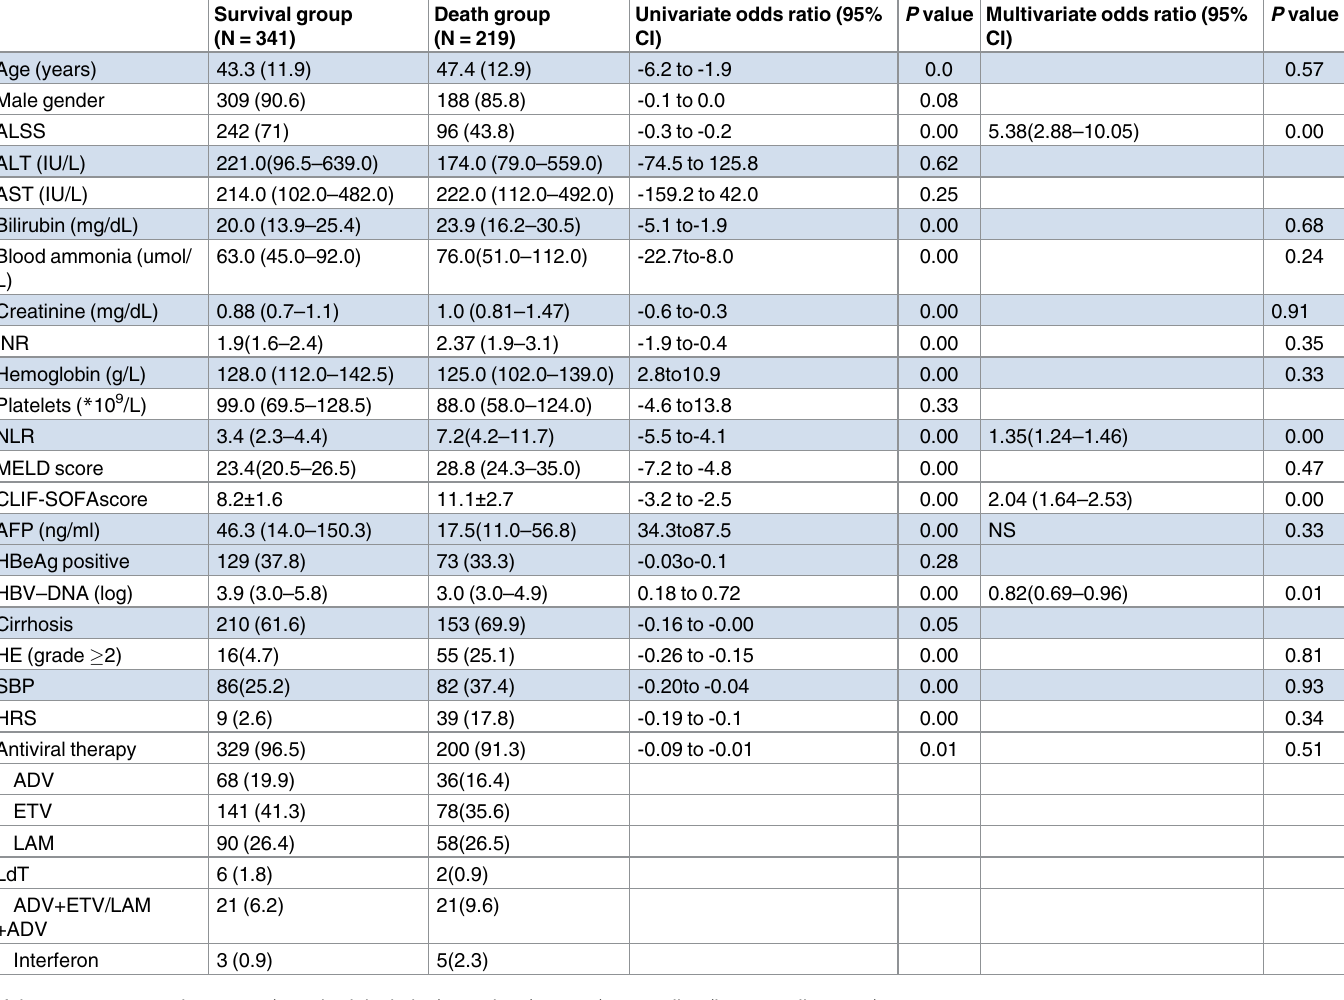
Table 2. Univariate and multivariate analysesof variables affecting 30-day mortality in whole